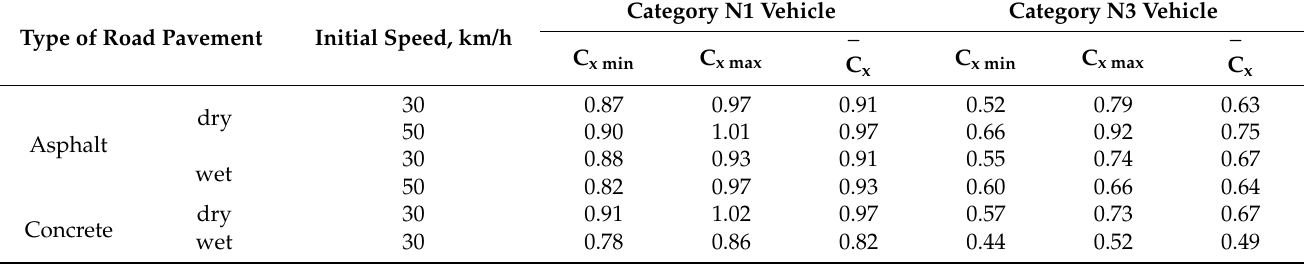
Table 9. List of C x coefficient values established for fully developed deceleration values. Table 8. List of C (cid:2934) coefficient values established for maximum deceleration values.